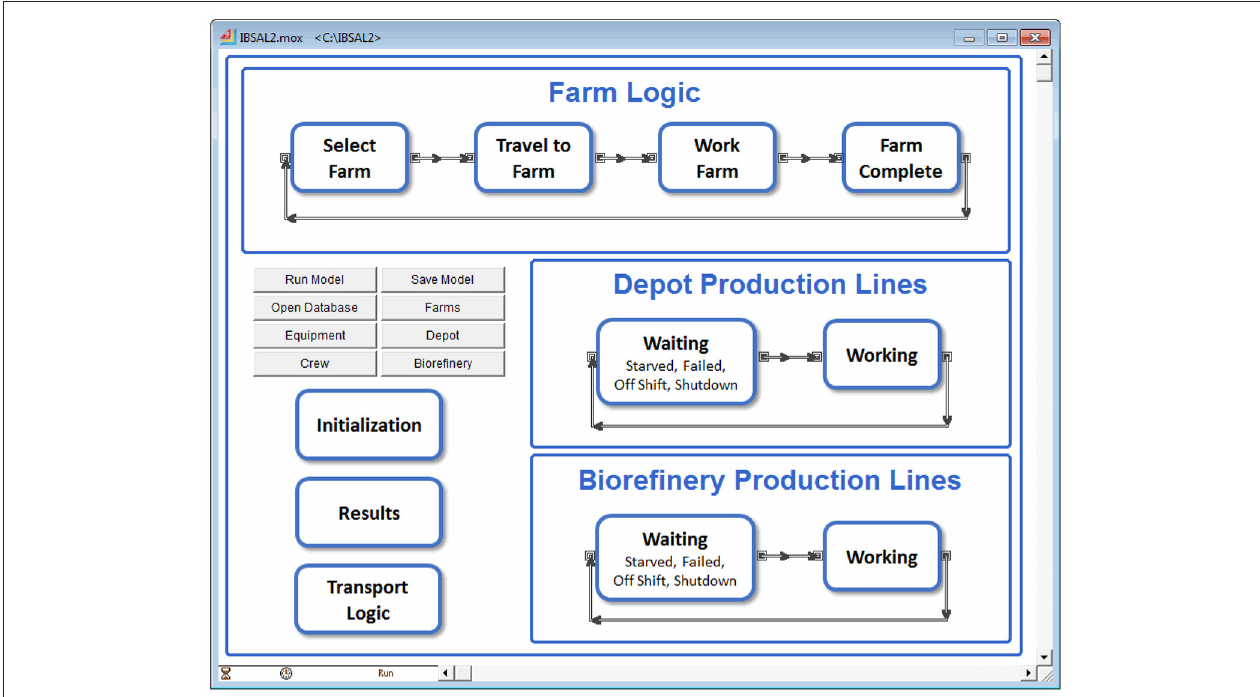
FIGURE 3 | Schematic of IBSAL 2.0 model logic and front-end interface developed using ExtendSim software.